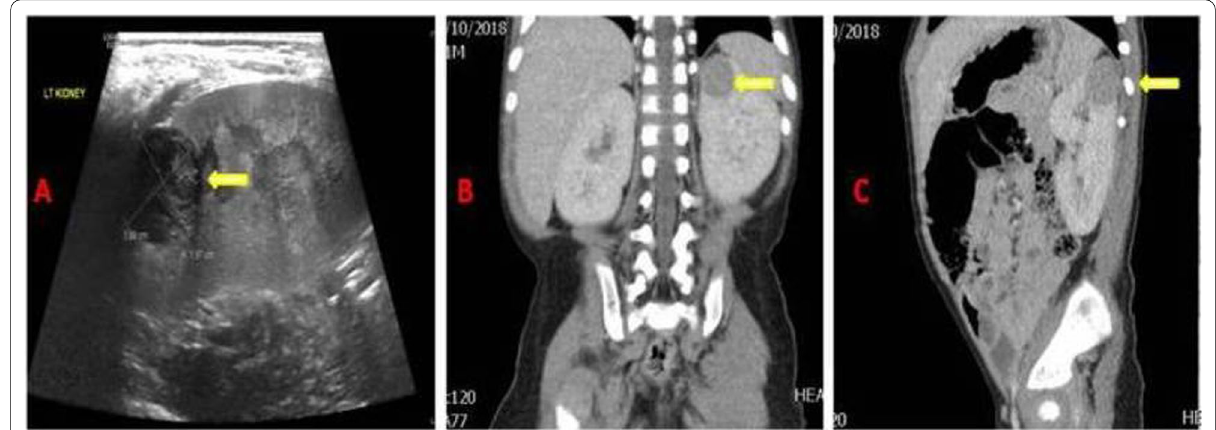
Fig. 1 Radiological evaluation. A Renal ultrasound documented a sharply marginated peripheral hypoechoic hypovascular mass at the upper pole of the left kidney measuring 2 2 cm. B , C Computerized tomography scan of the abdomen showing a partially exophytic homogenously × enhancing mass at the upper pole of the left kidney measuring 1.8 1.9 2 × ×